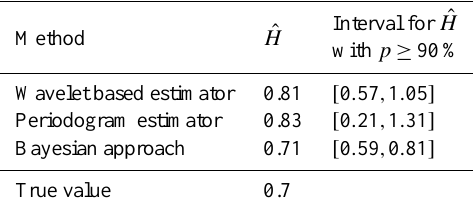
Fig. 4. The validation test for Bayesian estimation with 500 realiza- tions for the Hurst exponent H = 0 . 7. Table 1. The interval for ˆ H with p ≥ 90% for synthetic data with H = 0 . 7 and N =